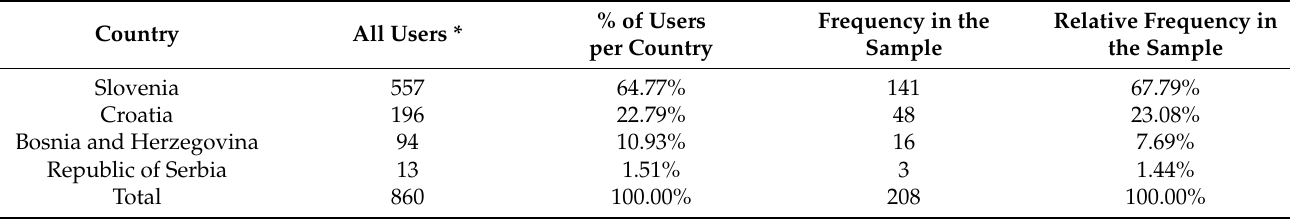
Table 1. Number of responses per country.